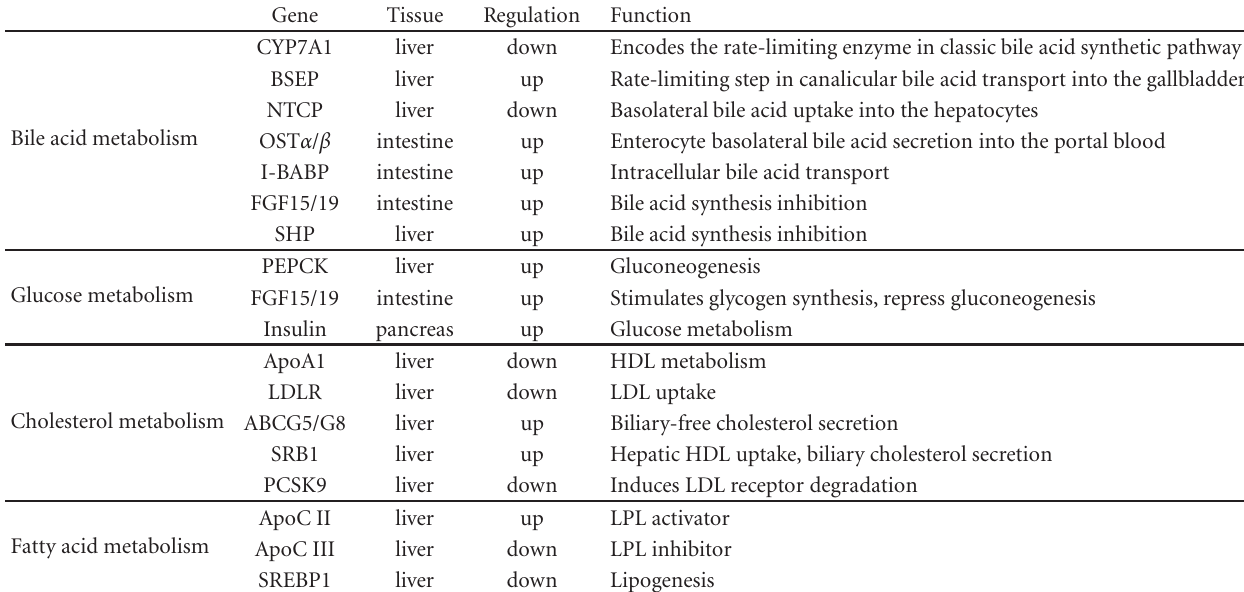
Table 1: FXR target genes and their function and lipid and glucose